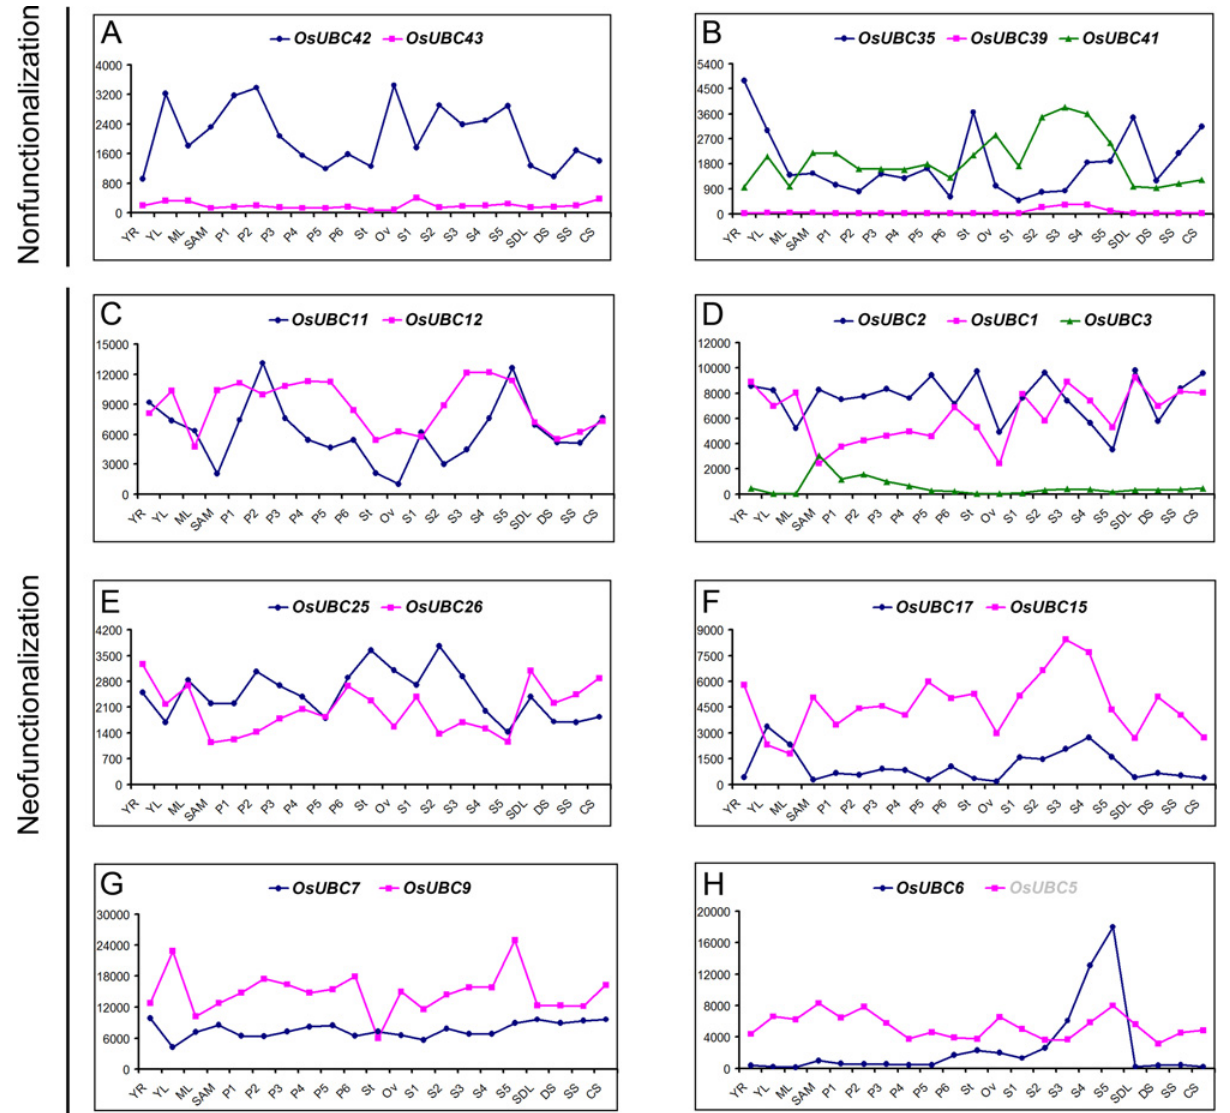
Fig 9. Expression divergence of paralogous OsUBC genes involved in duplication. The absolute values of duplicated genes obtained from microarray data were compared in various organs and under abiotic stresses. (A) and (B) Showing gene pairs described as non-functionalization; (C) to (H) Showing gene pairs described as